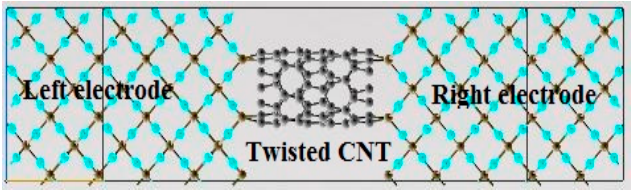
Figure 1. Two ‐ probe geometry in which twisted CNT is sandwiched between CrO 2 electrodes.